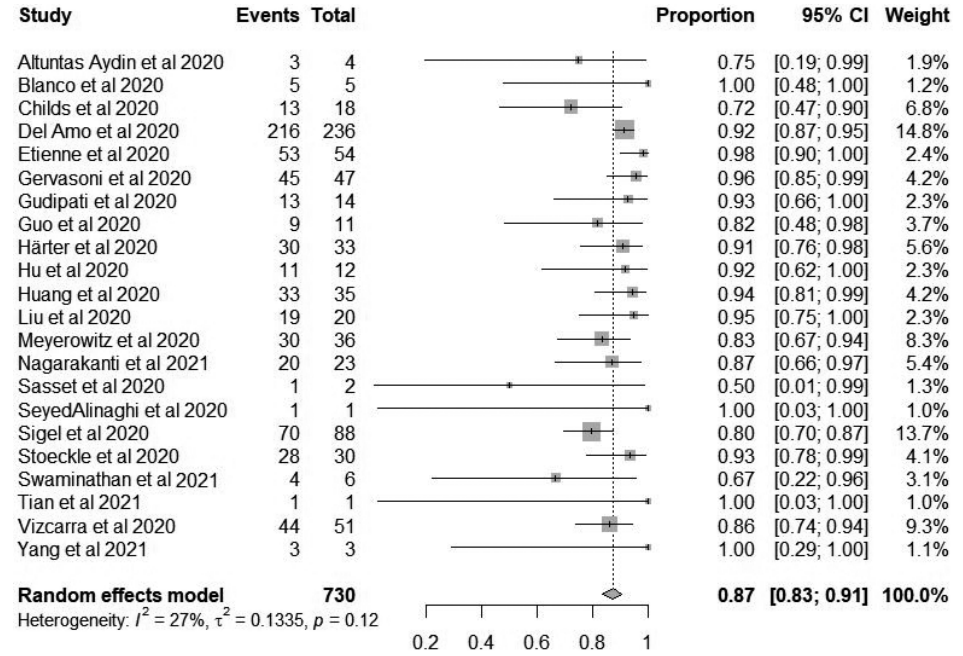
Figure 4. Forest plot for the recovery proportion of coronavirus disease 2019/human immunodeficiency virus-coinfected patients amongst the included studies. CI, confidence